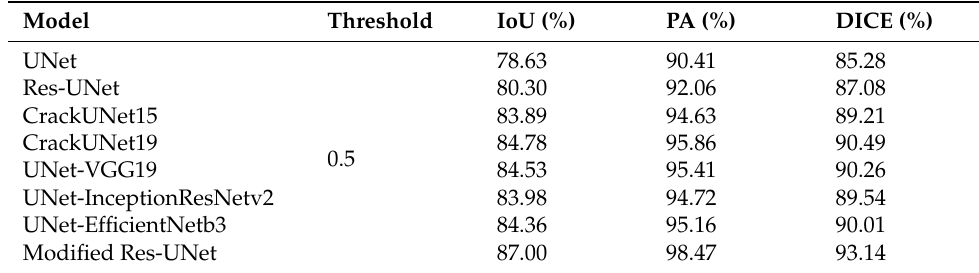
Table 2. The results of different UNet-base models on the test dataset.